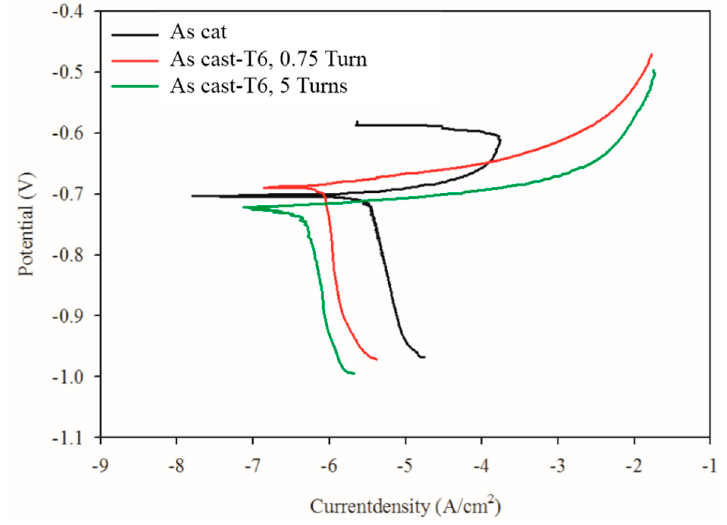
Figure 10. Polarization curves of the A356 Al alloy (as-cast) before and after HPT processing. Table 1. Average of the current density ( I corr ), corrosion rate (CR) and polarization resistance (R p ). Samples